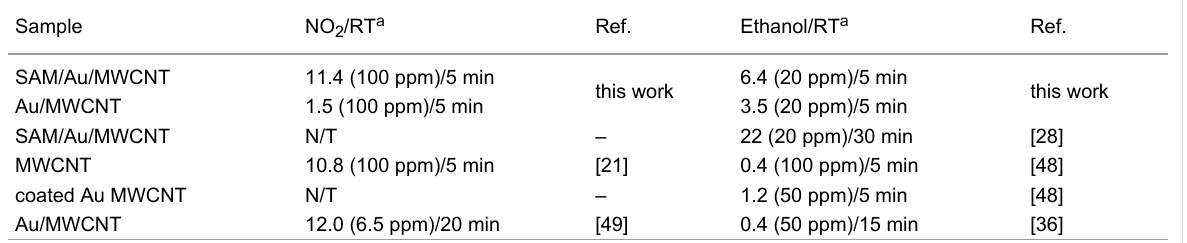
Table 1: Response (( Δ R / R 0 ) × 100) to nitrogen dioxide and ethanol with differently functionalized MWCNTs. N/T: Not tested. Sample NO 2 /RT